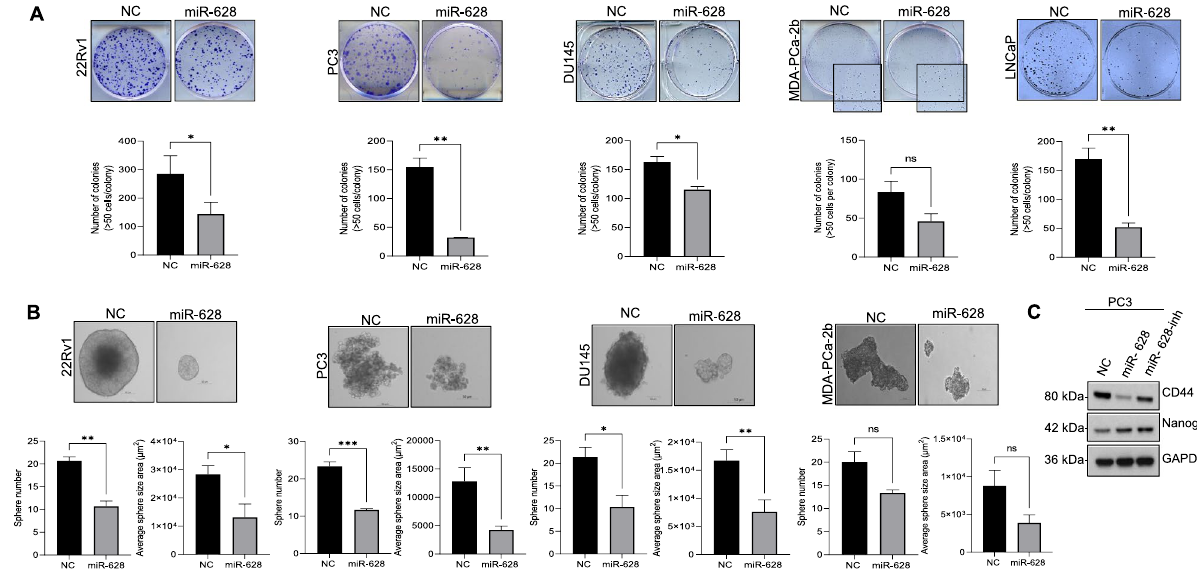
Figure 4. Expression of miR-628 affects cell colony and spheroid formation in PCa cells. ( A ) PCa cells were transfected with 100 nM of miR-628 or NC and cell colony formation assay was performed (upper panels) as described in the materials and methods section and the number of colonies was quantified using ImageJ and plotted using GraphPad PRISM (lower panels) *p < 0.05, **p < 0.01. ( B ) Spheroid formation assay was performed in PCa cell lines after transfected with 100 nM of miR-628 or NC as described in the materials and methods section. Images were captured using an inverted light microscope and representative images are shown at ×20 magnification (upper panels). The effect of miR-628 on spheroid number and sphere size was quantified using the Zeiss ZEN Blue lite software (lower panels) and plotted using GraphPad PRISM. Data represent average ± SEM. *p<0.05, **p< 0.01, ***<0.001. ( C ) Protein expression of CD44 and Nanog is shown in PC3 cells after transfection with 100 nM of miR-628 mimic, miR-628 inhibitor, or NC. Full-length images are provided in supplementary information